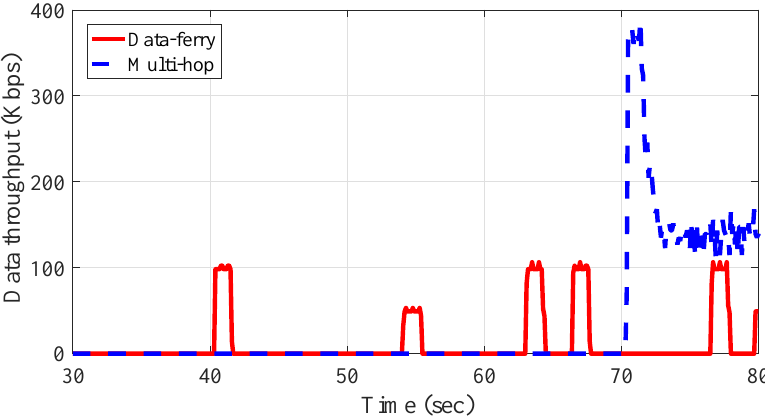
Figure 5. Throughput comparison between the data transfer